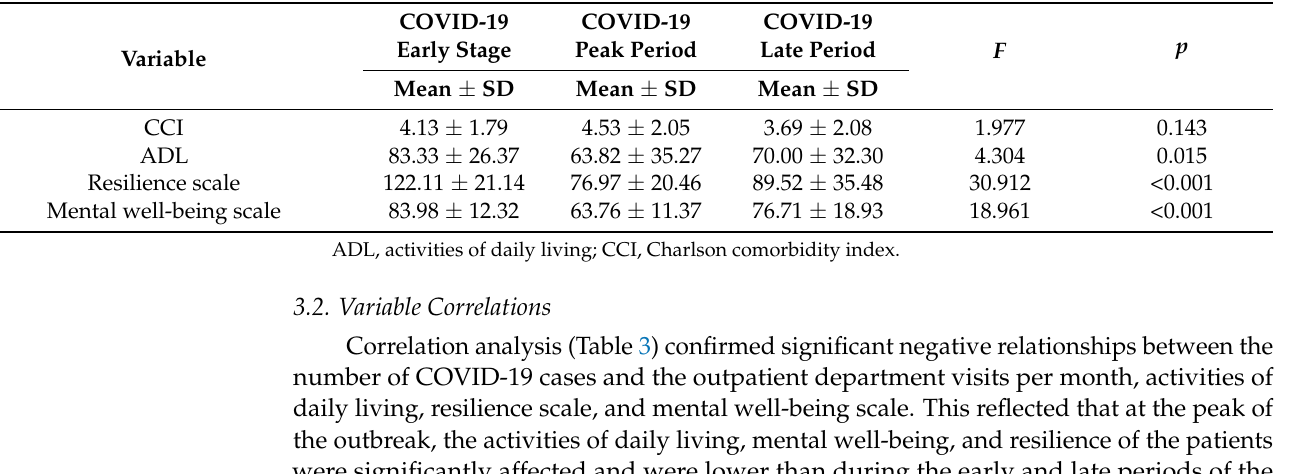
Table 2. Scale scores of the participants of the different periods of the COVID-19 outbreak in